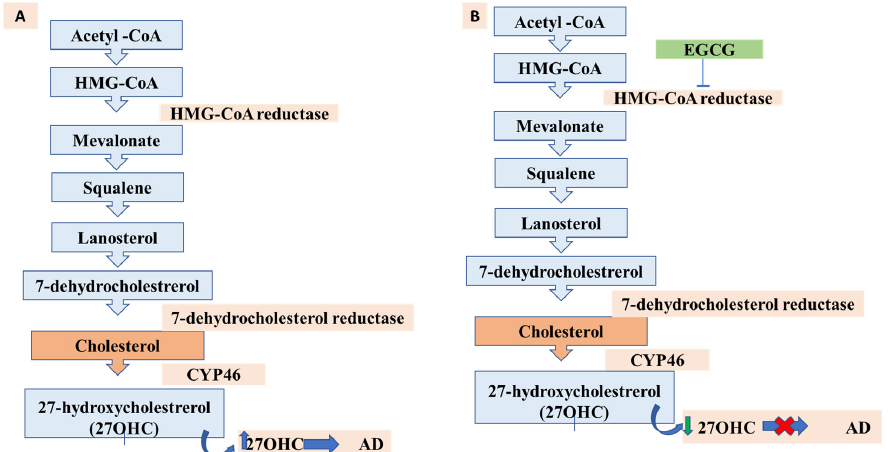
Figure 5. Contributing factors of cholesterol biosynthesis to AD genesis and possible inhibition by EGCG. ( A ) the normal cascade of events involves converting acetyl coenzyme A (Acetyl CoA) to 3-